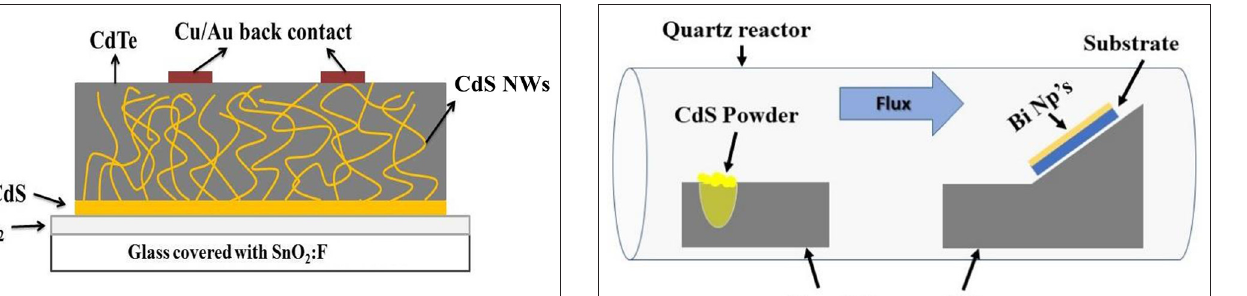
FIGURE 1 | Scheme of a prototype of solar cell using CdS nanowires. photoelectrons, becoming an excellent highly active photocatalyst for the production of hydrogen (Bao et al.,